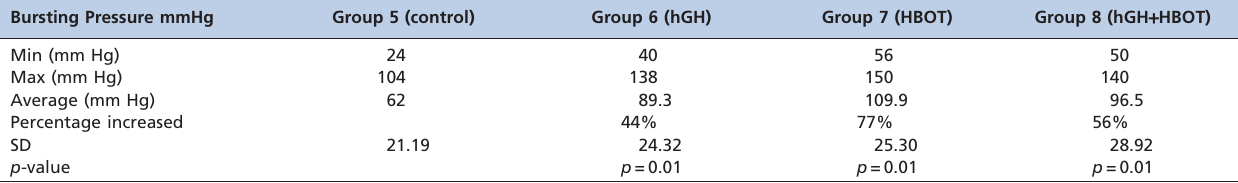
Table 2 - Bursting pressures in the ischemic groups. All of the values are expressed as the means ¡ SDs; SD: standard deviation. The p- value compares group 1 (control) to the other